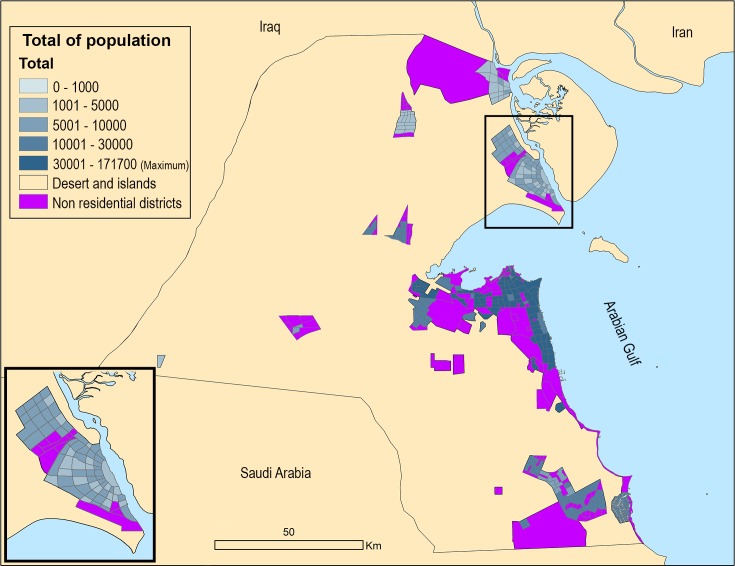
1st scenario population distribution.